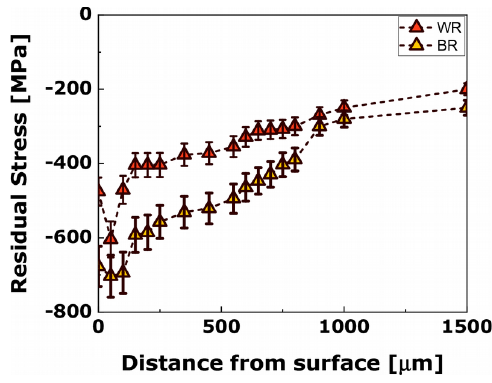
Figure 7. Residual stresses profile for a burnished sample (Sanguedolce et al., 2021)